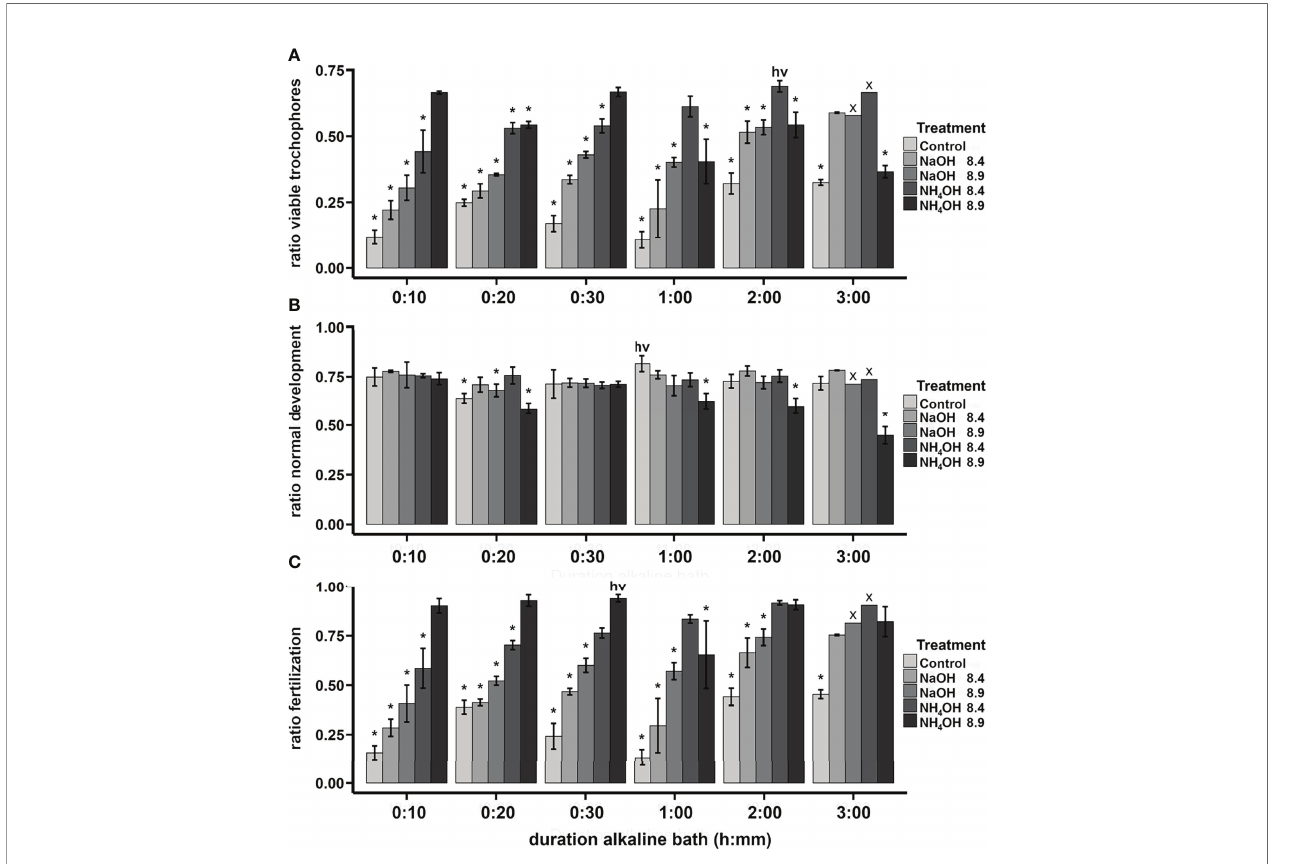
FIGURE 7 | P. aspera . First test to study the in fl uence of different alkaline baths on the larval production. Treatments combined different alkaline agents (NaOH and NH 4 OH), pH (8.4 and 8.9), and bath durations (10, 20, 30, 60, 120, and 180 min), plus negative control treatments. Bars indicate average ± SD. Asterisks indicate signi fi cant differences ( p < 0.05) with the treatment with highest value (hv). Marked treatments (x) were excluded from the analyses due to the lack of replicates. Ratio of viable trochophores (A) , ratio of normal development (B) , and ratio of fertilization (C)